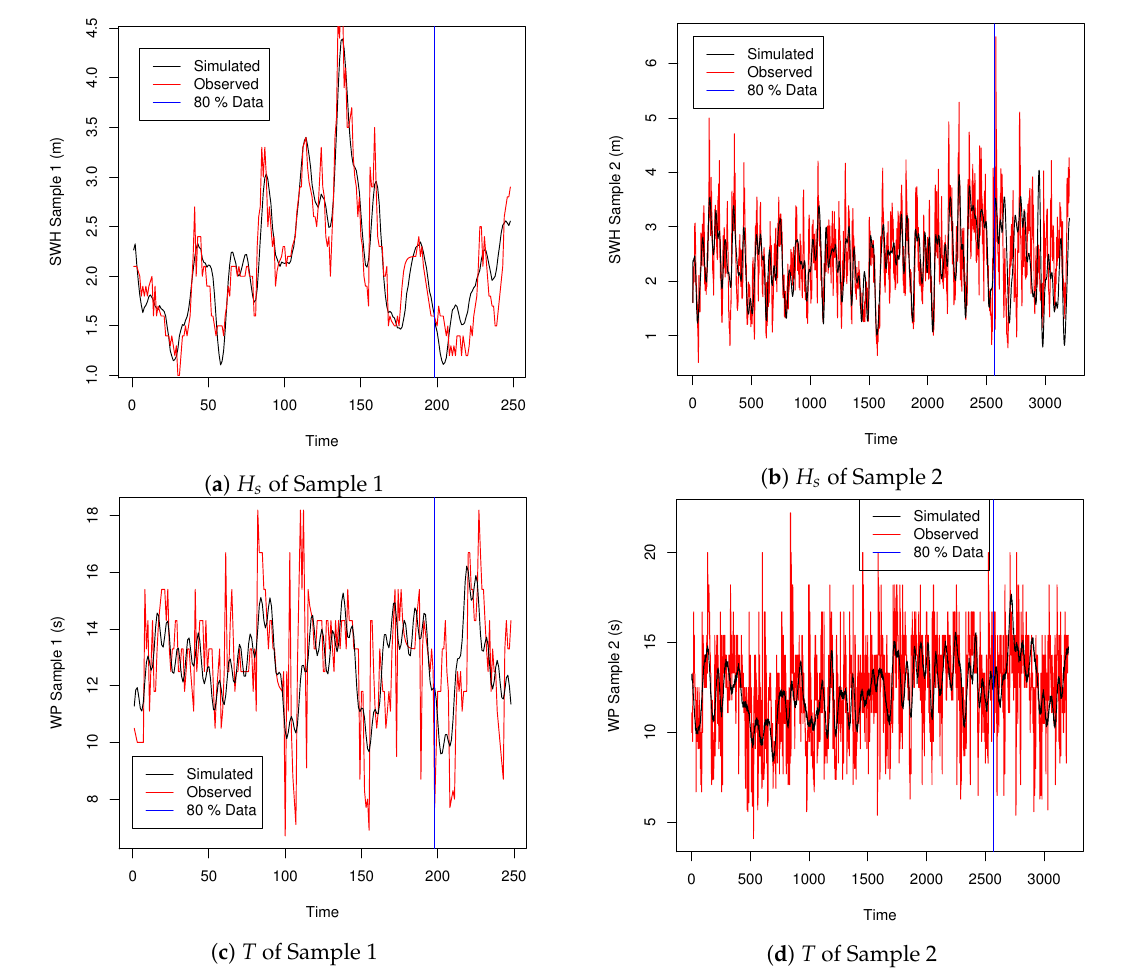
Figure 3. Simulated trajectories of H s and T